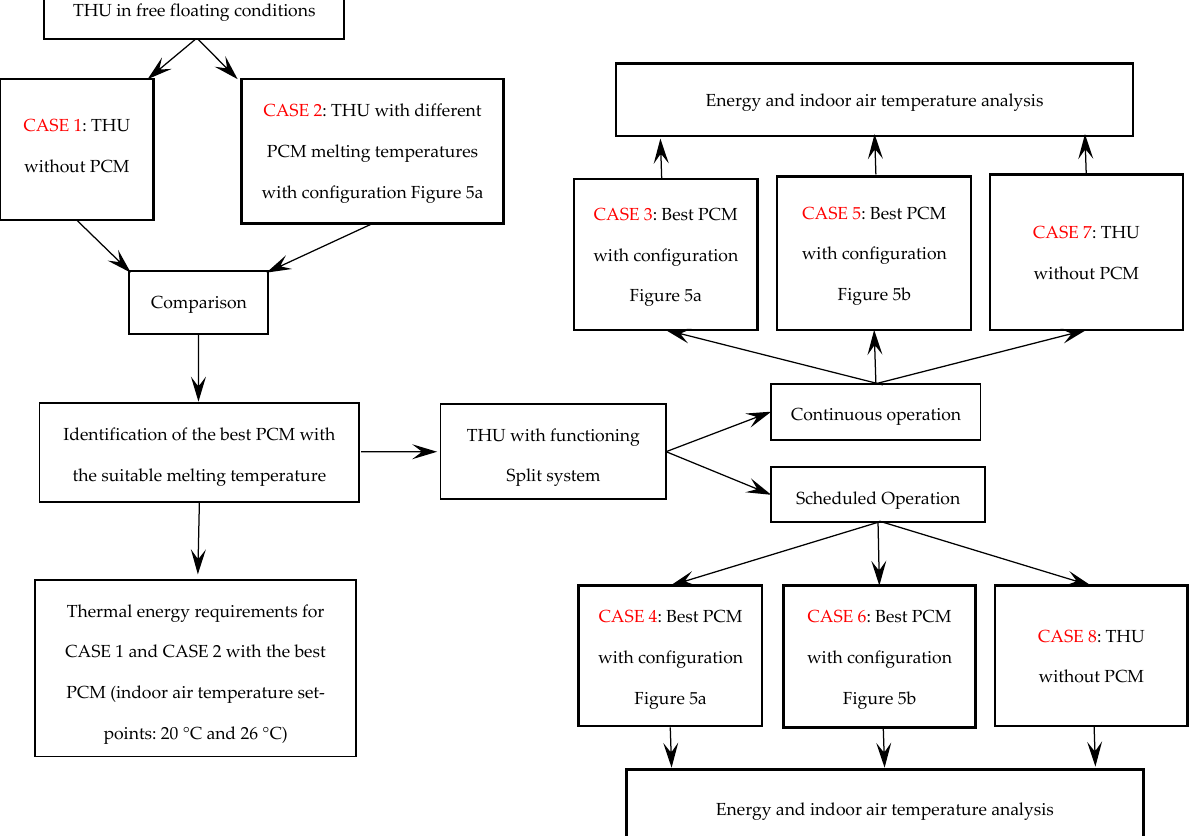
Figure 7. Flow chart explaining the steps followed in the cases considered in this investigation.